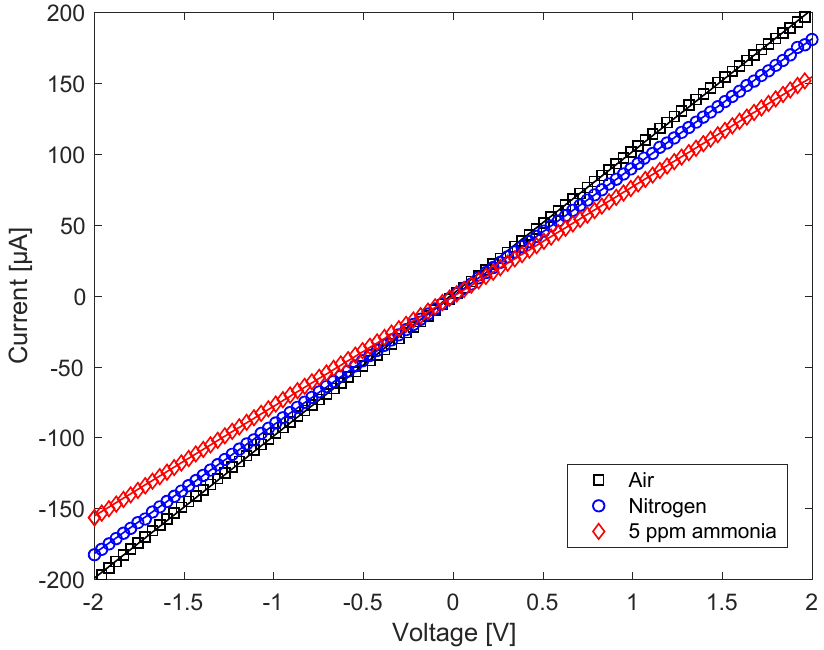
Figure 9. I − V curves of the V 2 O 5 nanosheets in air, in pure nitrogen, and with 5 ppm of ammonia in air.